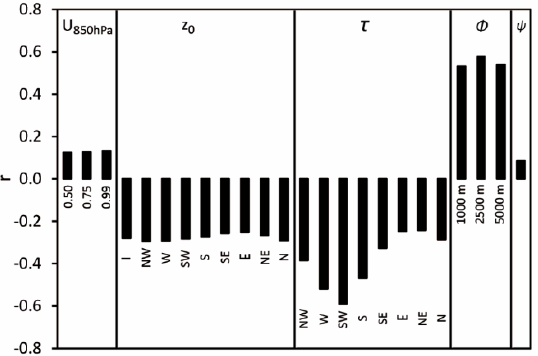
Figure 8. Correlation coefficient ( r )-values calculated between AEY mod and various predictor varibles.